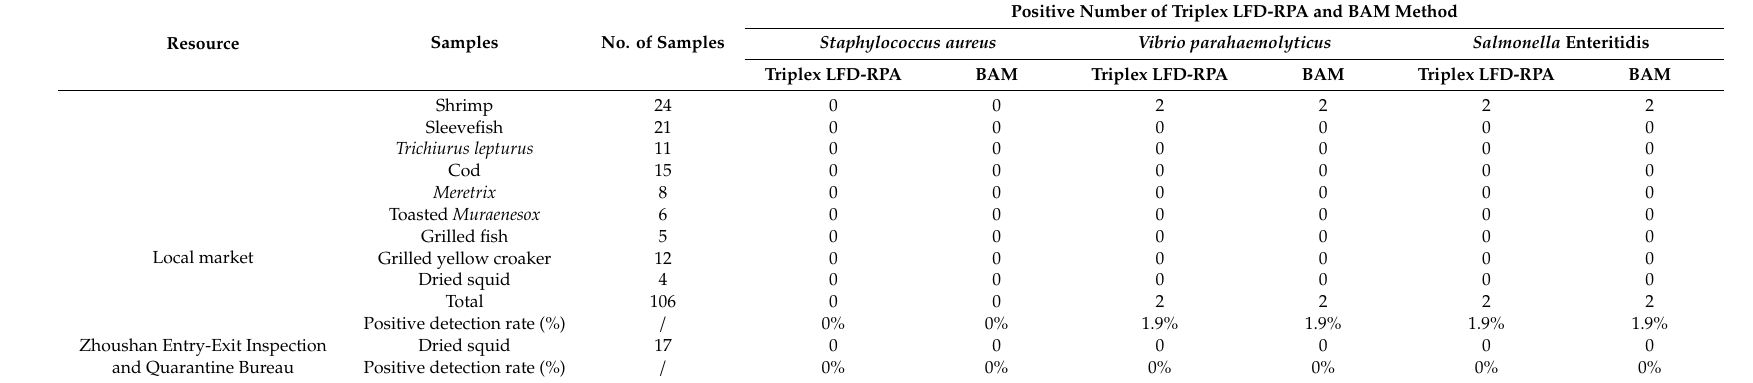
Table 4. Detection of unknown samples from the market by a triplex assay compared with the culture